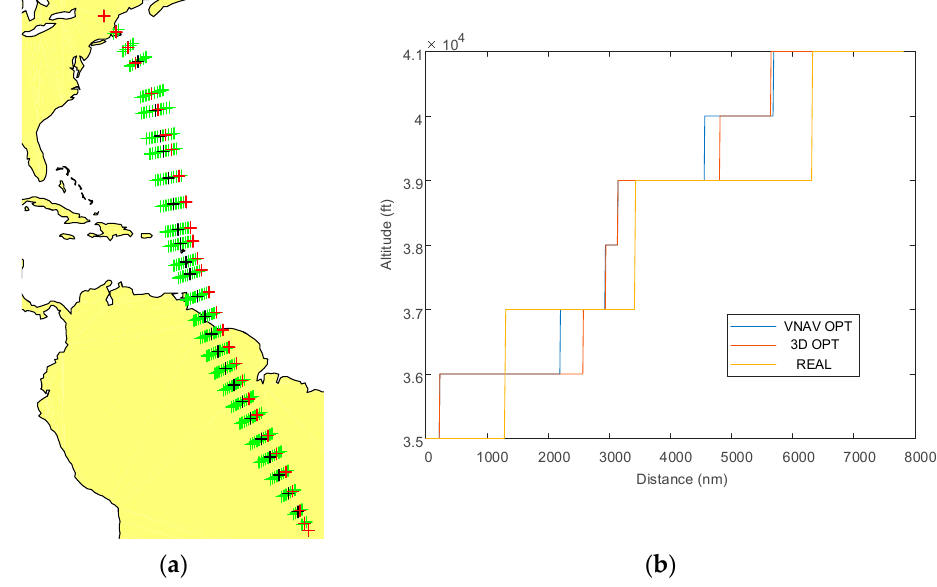
Figure 10. Lateral and vertical reference trajectory for the Flight between Montreal and Rio de Janeiro. ( a ) Lateral reference trajectory. ( b ) Vertical reference trajectory.